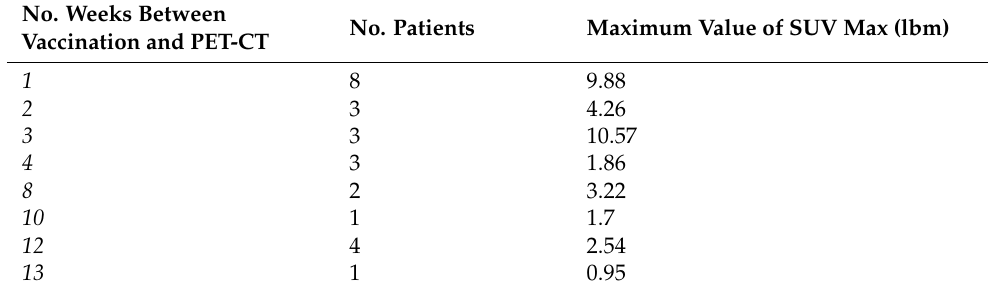
Table 3. Maximum value of SUVmax in concordance with the time interval between vaccination and PET-CT